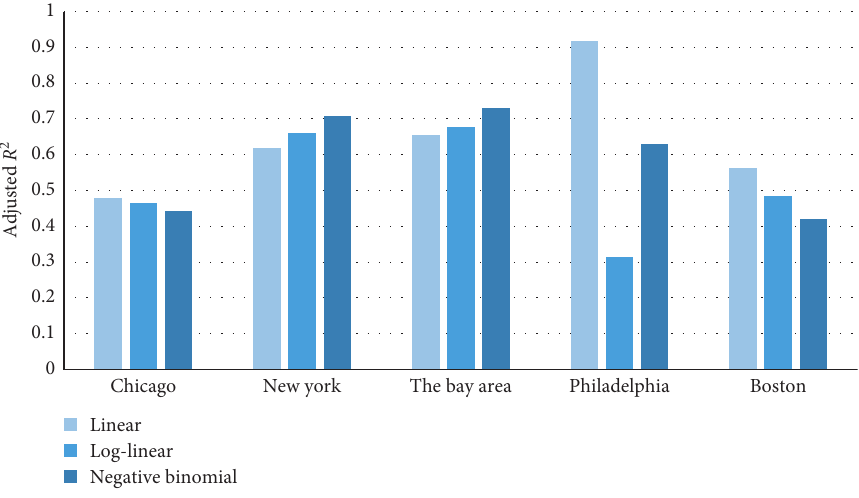
Figure 12: The result of three